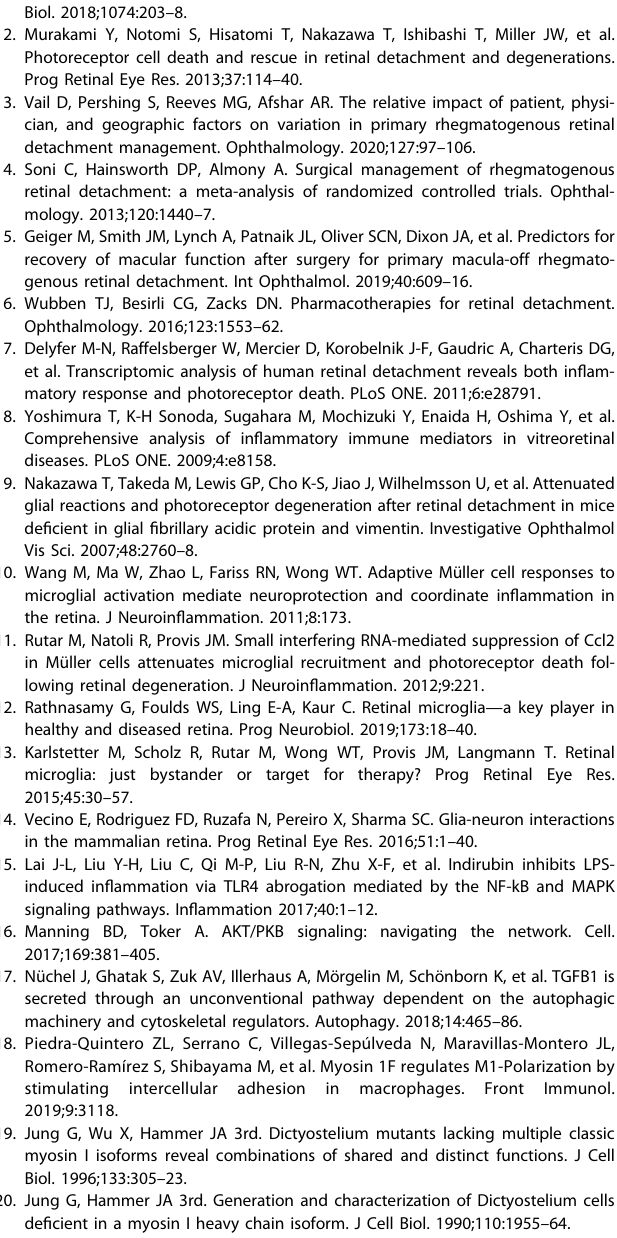
Fig. 6 Myosin 1f affects the activation of microglia by regulating AKT and MAPK pathways. A , B In vitro, western blot showed that myosin 1f is upregulated after stimulated by LPS (100 ng/ml) for 24 h ( A ), the expression value is calculated by the optical density ratio of myosin 1f and GAPDH ( B ). C The expression of IL-1 β (qPCR) and TNF- α (ELISA) at every time point. D , E After siRNA on BV2 cell lines, we detected the expression of myosin 1f by western blot ( D ). Three sequences of siRNA (768,1413,2772) were designed to knock down myosin 1f, 2662 were chosen to further con fi rm the ef fi ciency ( E ). F ELISA analysis of IL-1 β and TNF- α after knockdown myosin 1f. G Heatmap of RNA-seq from the detached retina of WT and myosin 1f − / − mice. H KEGG analysis of RNA-seq. I , J In vitro, western blot analysis showed an expression pattern of AKT and MAPK pathways ( I ). All the quanti fi cation of phosphorylation protein is calculated by the optical density ratio of phosphorylation protein and its corresponding protein ( J ). K , L In vivo, western blot analysis showed an expression pattern of AKT and MAPK pathways ( K ). All the quanti fi cation of phosphorylation protein is calculated by the optical density ratio of phosphorylation protein and GAPDH ( L ). M Graphical abstract of the effect of myosin 1f in the activation of microglia. Data were presented as mean ± SEM, unpaired t test, *P < 0.05, **P < 0.01, ***P < 0.001, ****P <